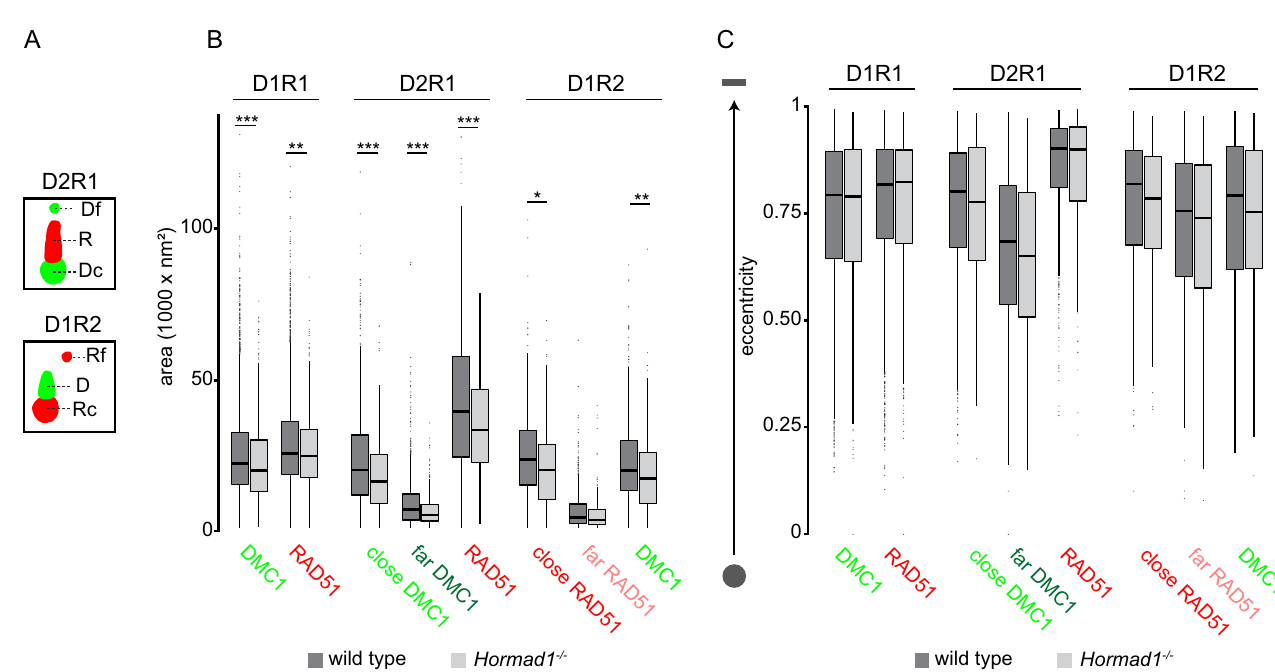
Fig 4. Characterization of DSB configurations based on shape features of individual nanofoci. A) Schematic representation of the nomenclature of each nanofocus within D2R1 and D1R2. RAD51 (R) and DMC1 (D) nanofoci within D2R1 and D1R1 are defined as follows: the closest nanofocus to the nanofocus of the other protein is called the close nanofocus (Dc, Rc) and the other nanofocus is called the far nanofocus (Rf, Df). B) Boxplot of area of RAD51 and DMC1 nanofoci for D1R1, D2R1 and D1R2 configurations for wild type and Hormad1 -/- . C) Boxplot of eccentricity of RAD51 and DMC1 nanofoci for D1R1, D2R1 and D1R2 configurations for wild type and Hormad1 -/- . For D2R1 and D1R2, a distinction was made between far and close nanofoci as defined in A. To visualize the relation between eccentricity and shape we depicted two schematic examples on the left: a low eccentricity value represents a round/sphere shape and a high eccentricity value represents a more oval/line